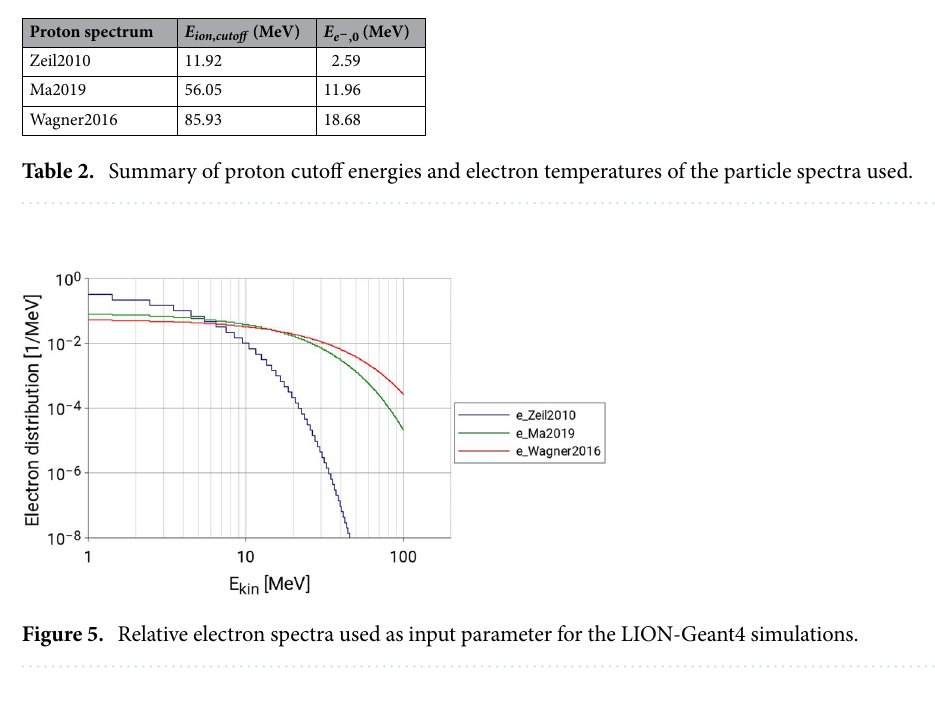
Proton spectrum